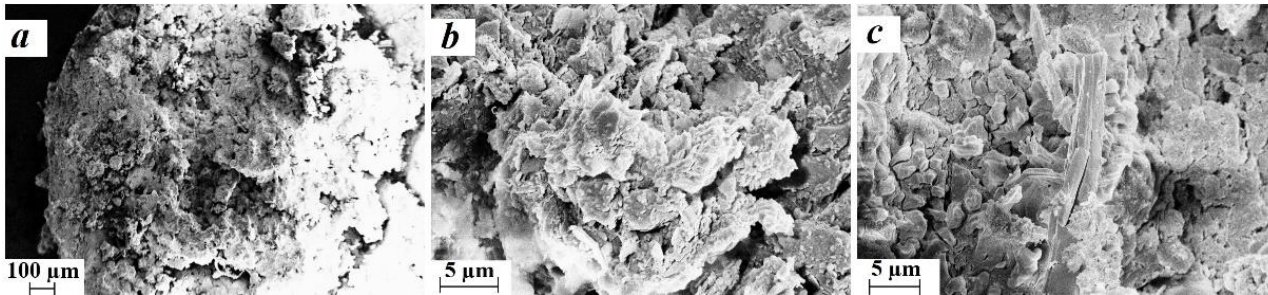
Figure 2. SEM images of the morphology ( а ) and the surface of copper-nickel tailings granules ( b , c ).